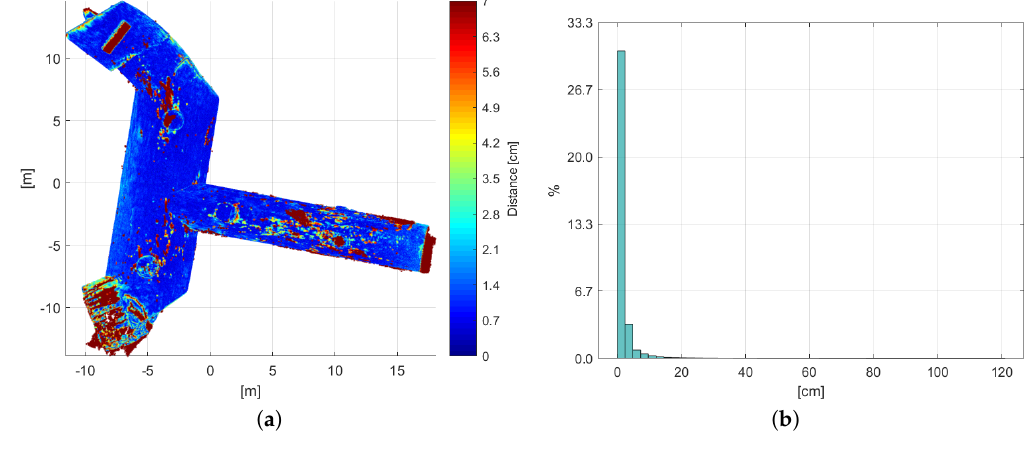
Figure 8. Photogrammetric 3D model (with optimal scale factor) accuracy assessment: comparison with the TLS 3D model. Point clouds registered in local coordinates with the ICP algorithm. ( a ) Map of point-to-point distances. ( b ) Histogram of distances shown in ( a